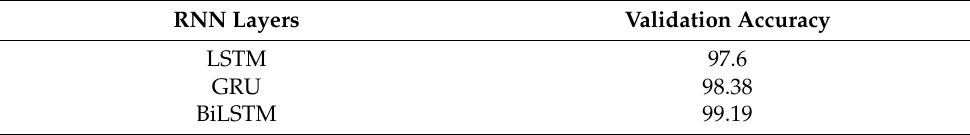
Table 3. Accuracy comparison with RNN